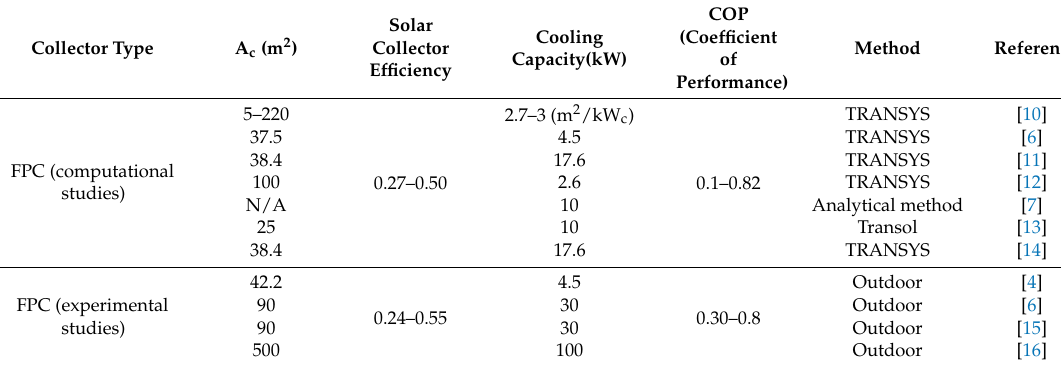
Table 1. Summary of FPC (flat plate collector) for solar absorption cooling